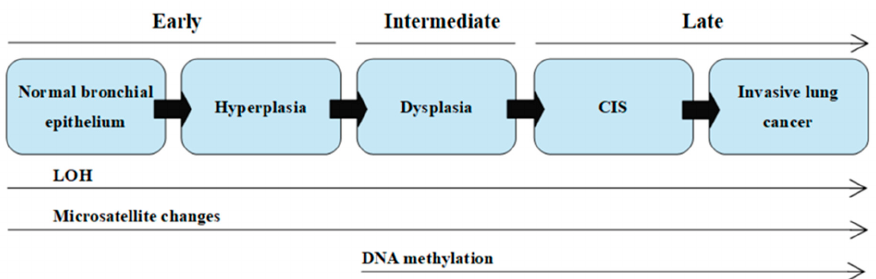
Figure 1. Scheme of the sequential changes during carcinogenesis in a simplified manner. LOH—loss of heterozygosity; CIS—carcinoma in situ. On the basis of (own modification of [7]).